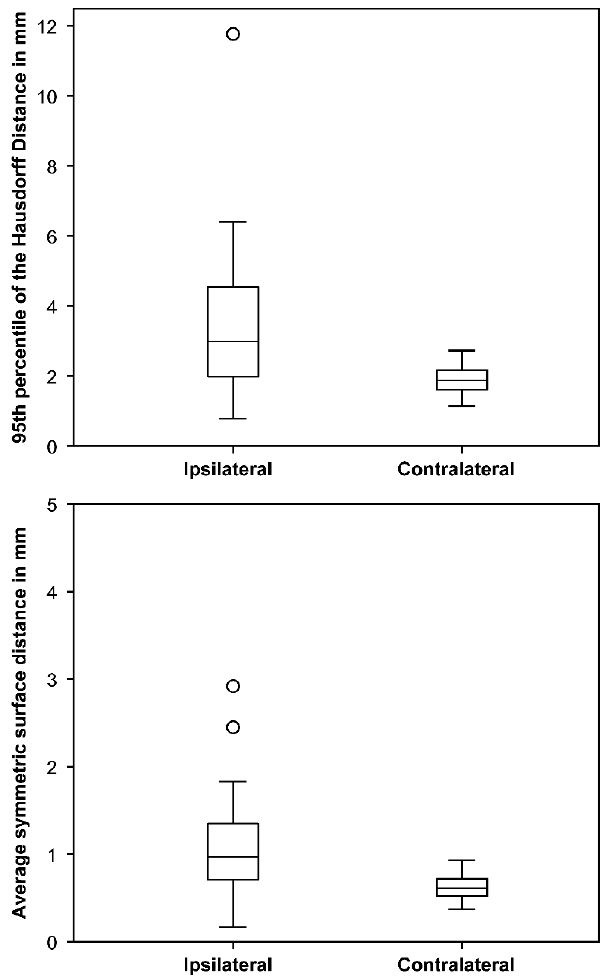
Figure 5. Maximal (95th percentile of the Hausdorff distance) and average symmetric surface distances between optic nerves contoured in MRI and CT in mm indicating larger differences for the ipsilateral nerve. Boxplots showing median and interquartile range, whiskers indicate maximum and minimum within a 1.5 interquartile range, circles indicate outliers.